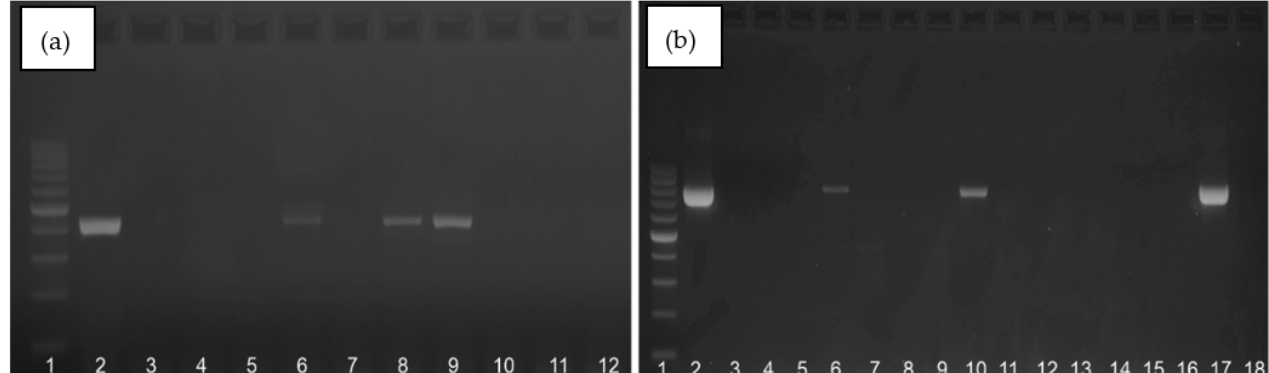
Figure 2. Exemplary results of electrophoresis for GBS detection based on 16S rRNA gene—405 bp ( a ) and atr gene—780 bp ( b ). First paths on ( a , b )—DNA size marker (100–1000 bp, A & A Biotechnology, Gda´nsk, Poland), second paths—positive control (DNA isolated from S. agalactiae ATCC 12386), other paths—the tested samples. Paths number 12 ( a ) and number 18 ( b )—negative controls—nuclease-free water (A & A Biotechnology, Gda´nsk, Poland).